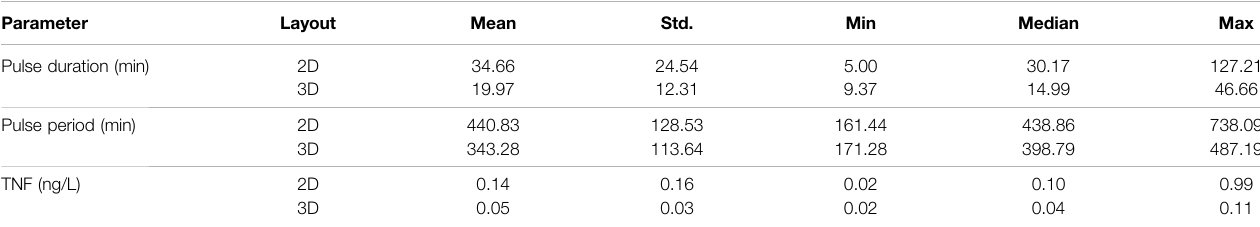
TABLE 1 | Summary statistics for the parameters from the effective treatments found by sampling 10,000 random candidates. Parameter Layout Mean